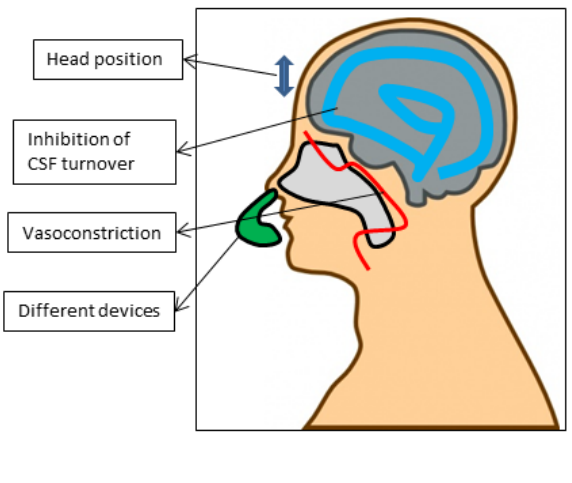
Figure 3. Factors that can influence the efficacy of intranasally administrated substances, with the focus on indirect